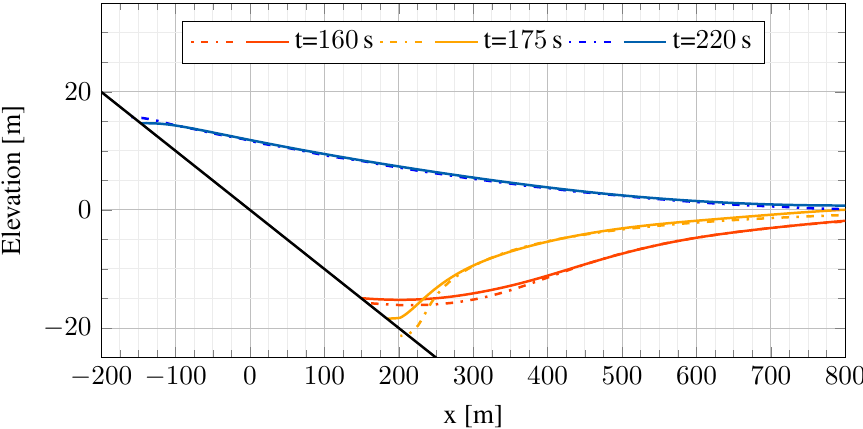
Figure 6. Free surface in the runup region. ELBE results (solid lines) in comparison to the reference nonlinear shallow water (NSW) solution of [40] (alternating dots and dashes) for three points in